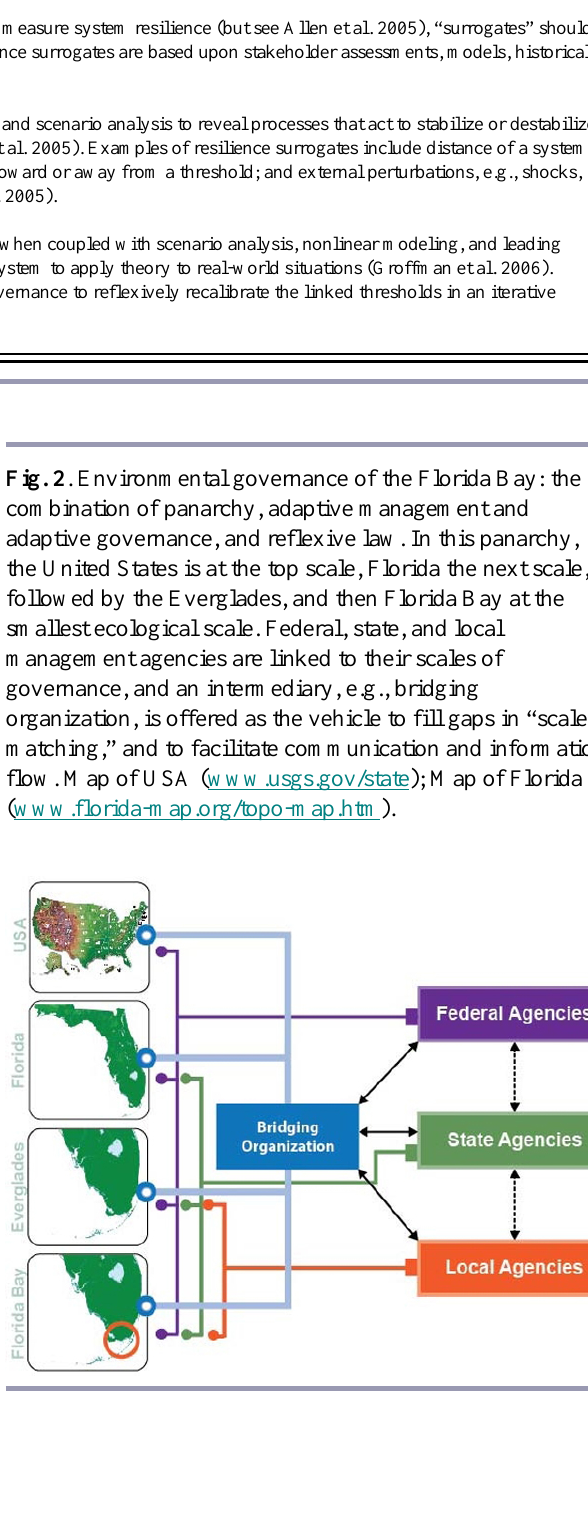
Table 1 . Summary of elements necessary for the integration of resilience science, i.e., panarchy, adaptive management and adaptive governance, and reflexive law as applied to the Florida Bay example.